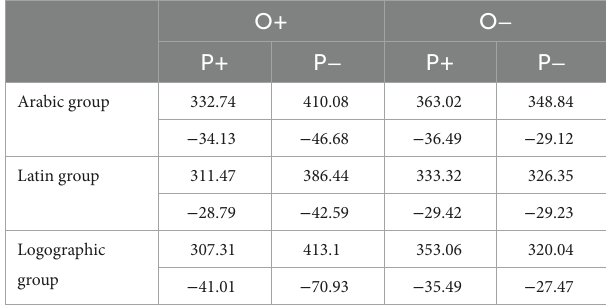
TABLE 6 By-item reaction time (ms) means and standard